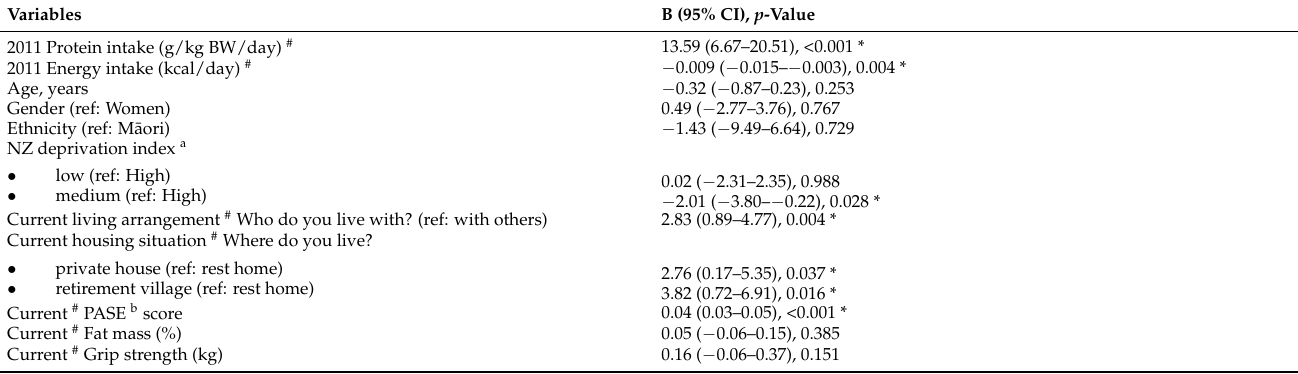
Table 3. Multivariate Regression Model Examining the Relationship between 2011 Protein Intake, as Predictor, and 2021 NEADL Score in all Participants #